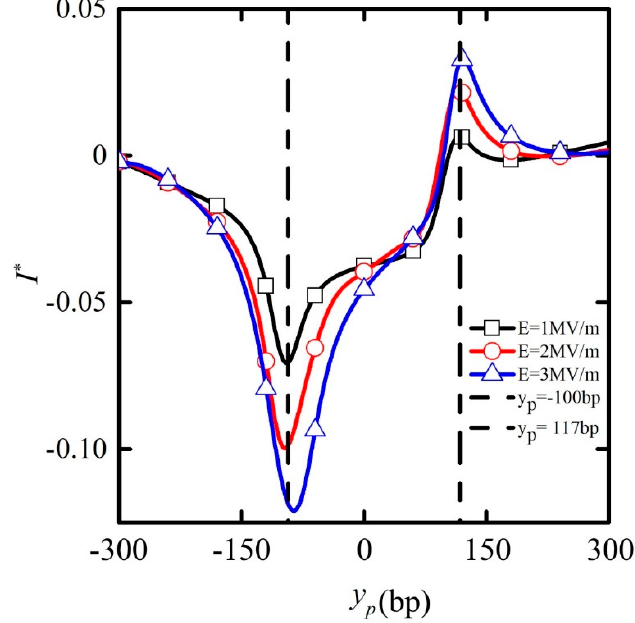
Figure 6. The ion current deviation I * passing through the nanopore depending on the particle position under E = 1 (black line plus frame), E = 2 (red line plus circle), E = 3 MV / m (blue line plus triangle) when the particle length is L p = 200 bp. Dotted lines indicate the particle position y p = − 100 and y p = 117 bp, and are not meant to indicate locations for maximum or minimum current.